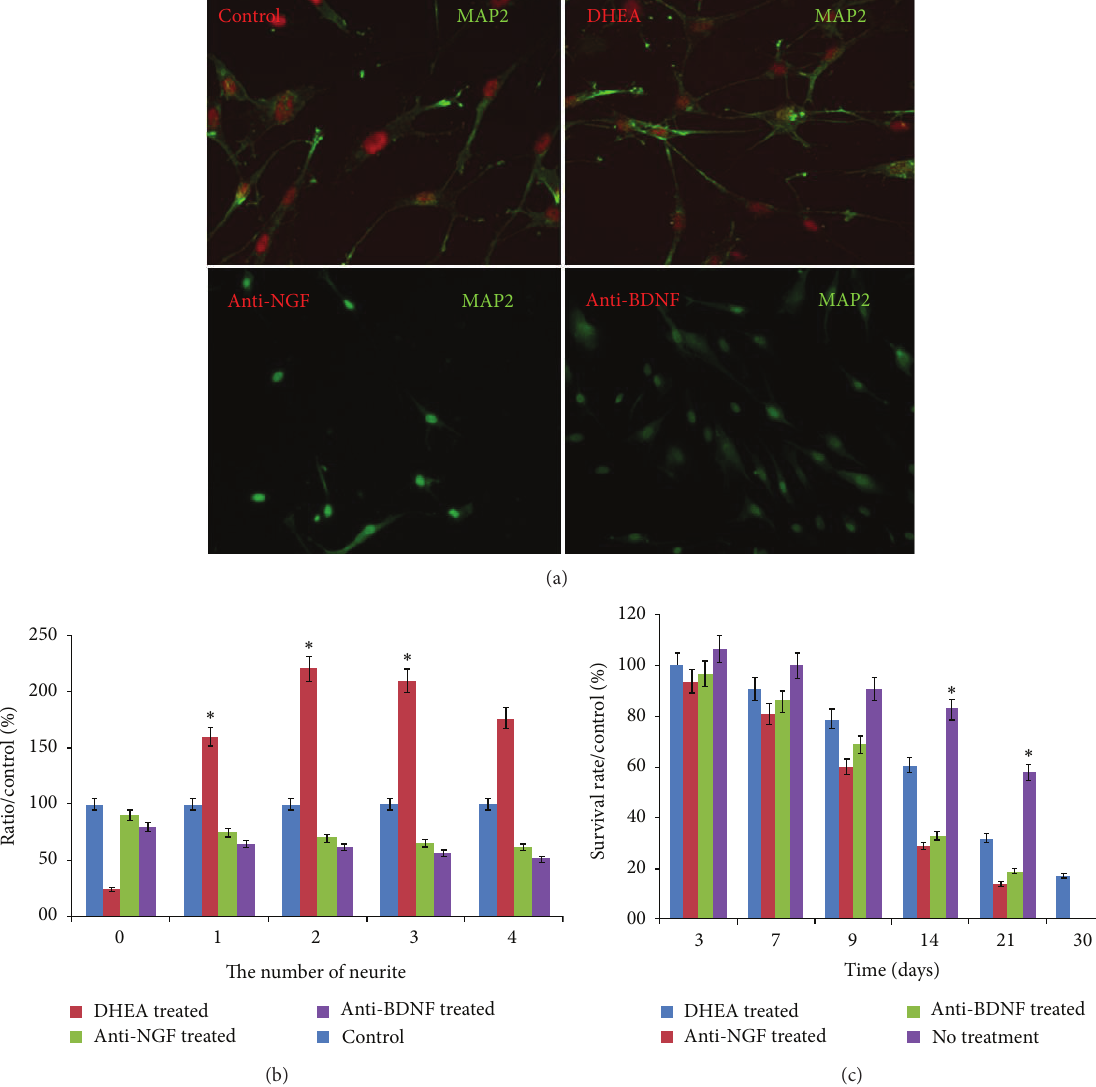
Figure 3: DHEA induced upregulation of NGF and BDNF facilitated the differentiation of rat cortical neurons. Neurons from the DHEA treated rats were immunostained against neuronal marker MAP-2 (a). The number of neurite extending from each neuron is demonstrated. Anti-NGF and anti-BDNF antibodies (1 𝜇 g/mL) were used to block NGF and BDNF action from DHEA treated groups (b). Effects of chronic DHEA treatment on cell proliferation and survival via MTT assay (c). Data represent the mean ± S.D. In each experiment, the data were obtained from nine